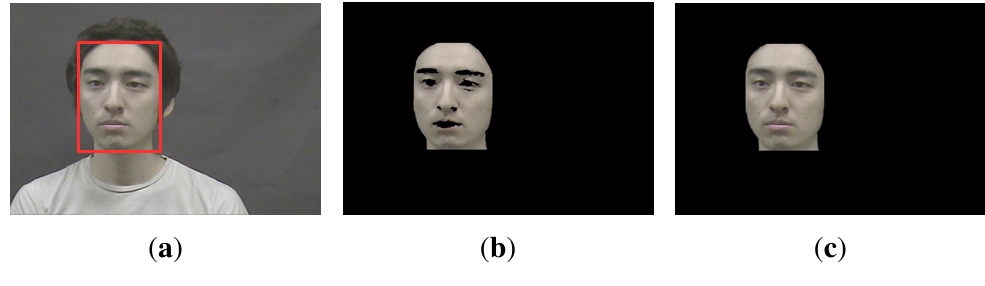
Figure 6. face region extraction: ( a ) result of Viola-Jones detector; ( b ) result of skin color detection; and ( c ) final resulting image of the morphology operation.